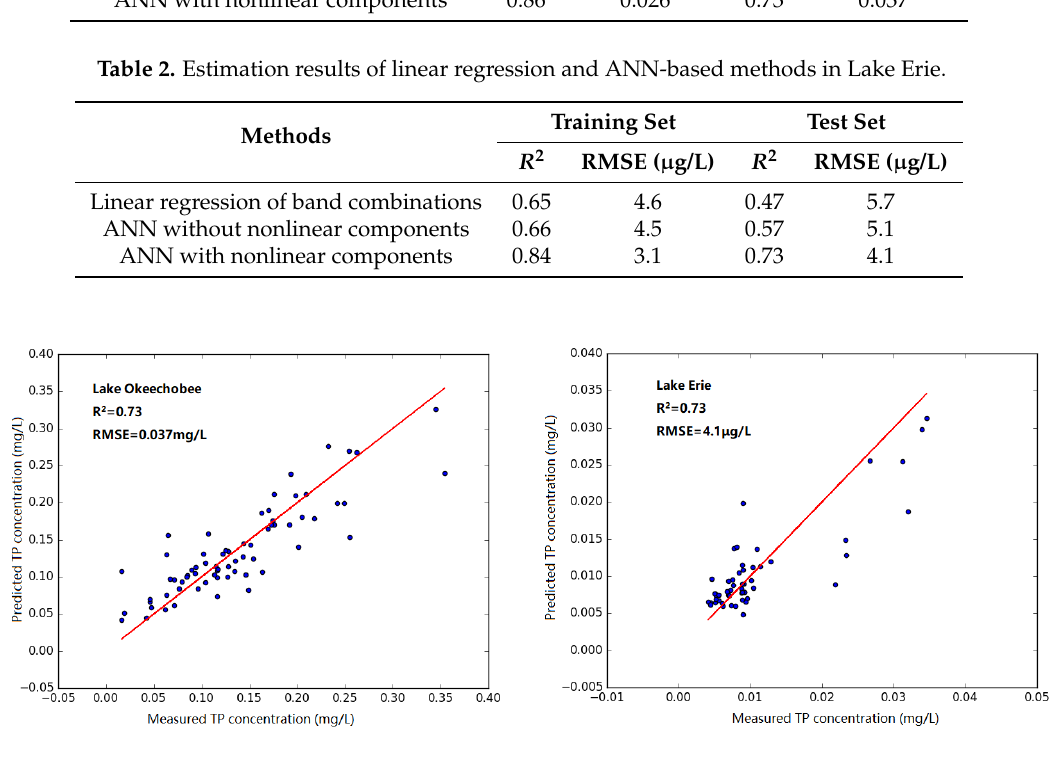
Figure 3. Distributions of predicted TP concentration in test set by ANN. The red solid line shows a 1:1 correspondence between the measured TP concentration and predicted TP